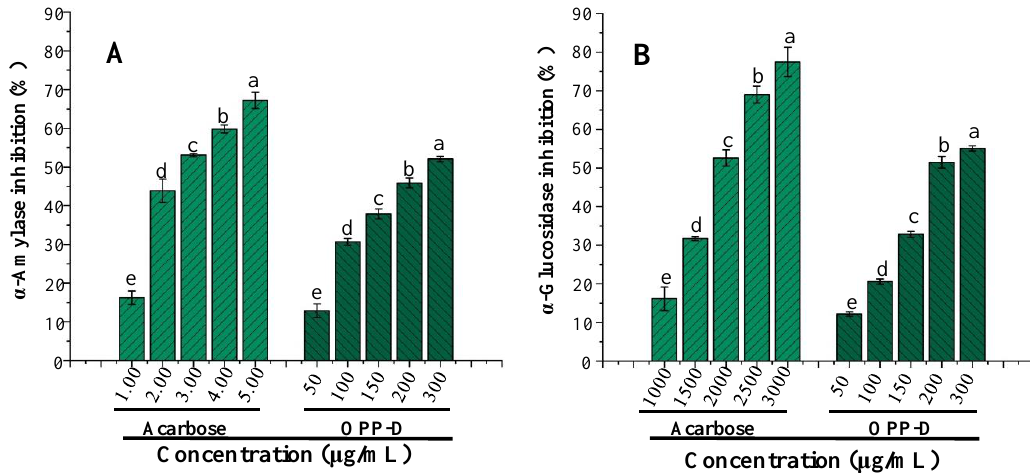
Figure 7. In vitro inhibitory activities on α -amylase ( A ) and α -glucosidase ( B ) of OPP-D. The error bars are standard deviations. Significant ( p < 0.05) differences are shown by data bearing different letters (a – e). Statistical significances were carried out by ANOVA and Duncan’s test.